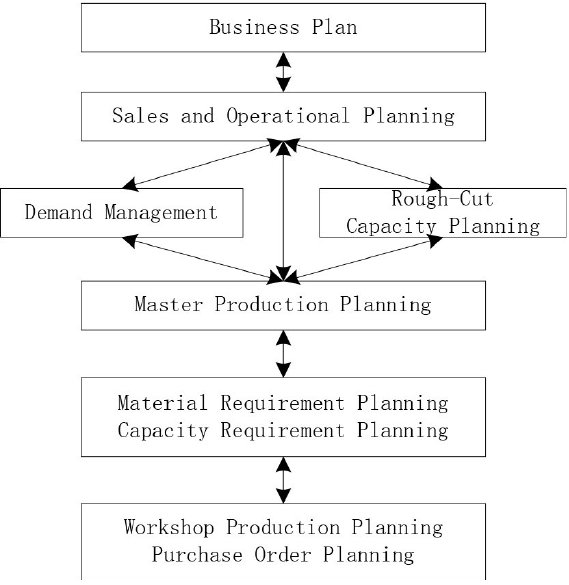
Figure 1. ERP Planning